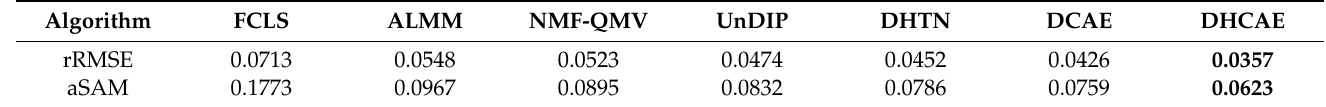
Table 6. Quantitative performance on the Washington DC Mall dataset by various approaches. The best result is shown in bold.